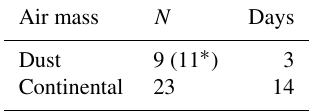
Table 2. Overview of the number of samples ( N ) available for INP closure in dust-dominated and continental air mass cases. Addition- ally, the number of days over which the samples are taken is